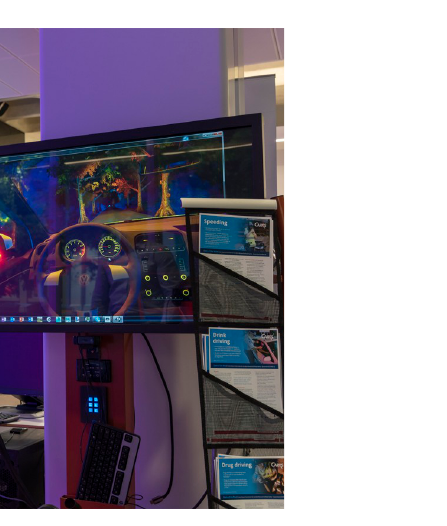
Fig 6. A participant driving under the VR-simulated influence of magic